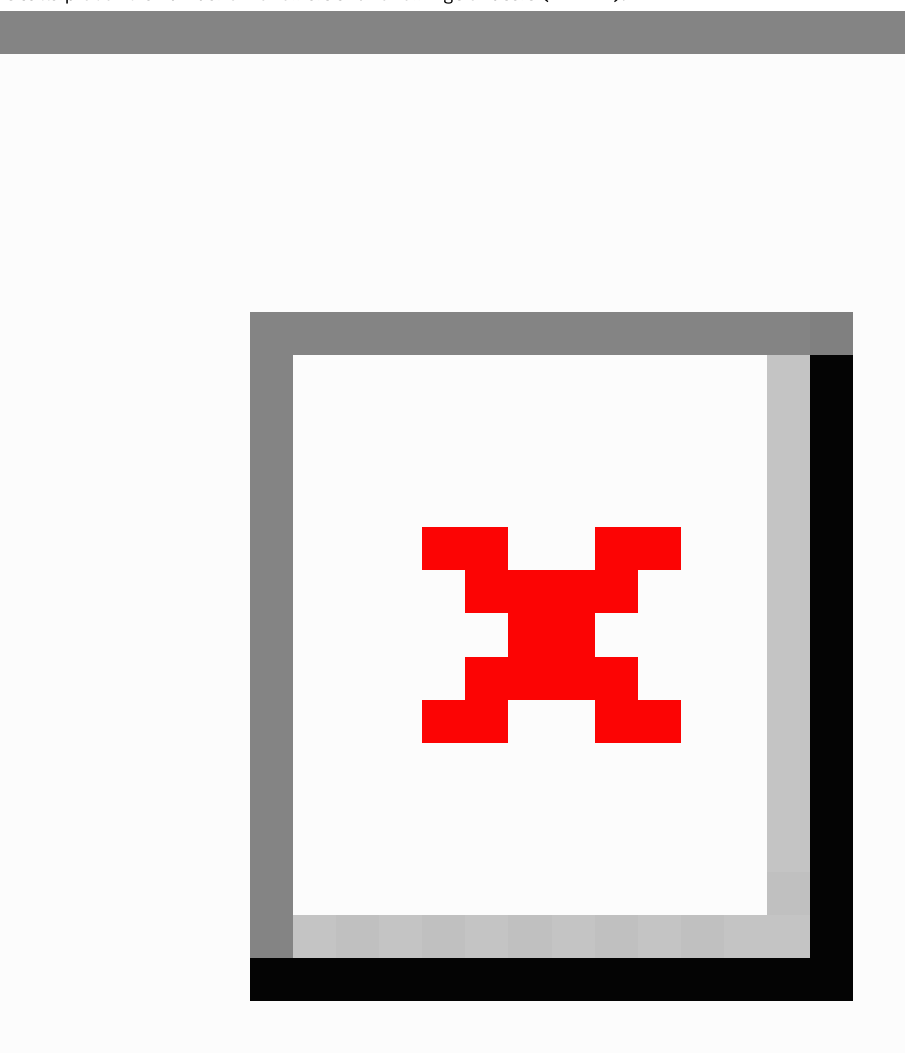
Figure 2. Scatterplot of the number of followers and followings of users